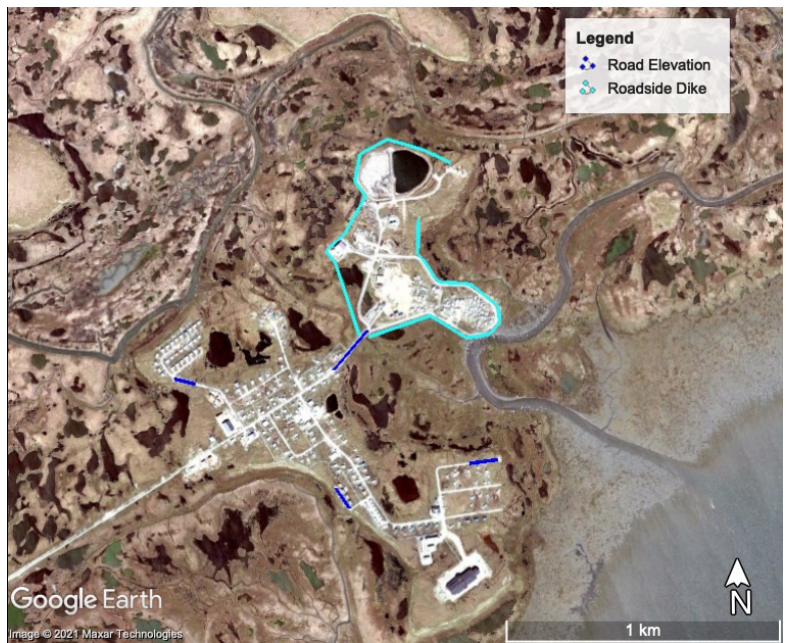
Figure 6. Planned roadside dike mitigation.